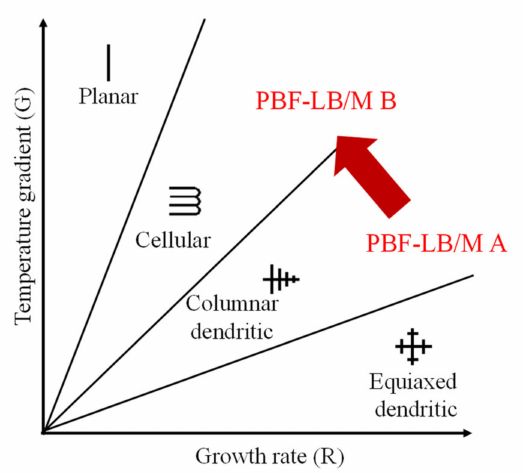
Figure 4. Backscattered electron (BSE) images of sample PBF-LB/M B showing visible melt tracks with coarser structures at the inter layer boundaries.